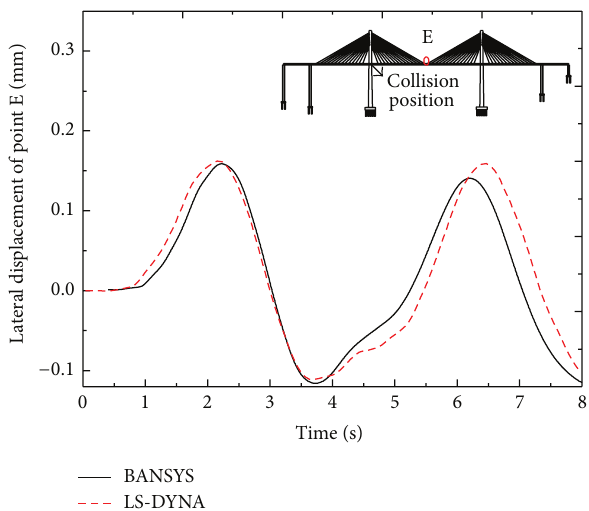
Figure 9: Lateral displacement of the girder in the mid-span.